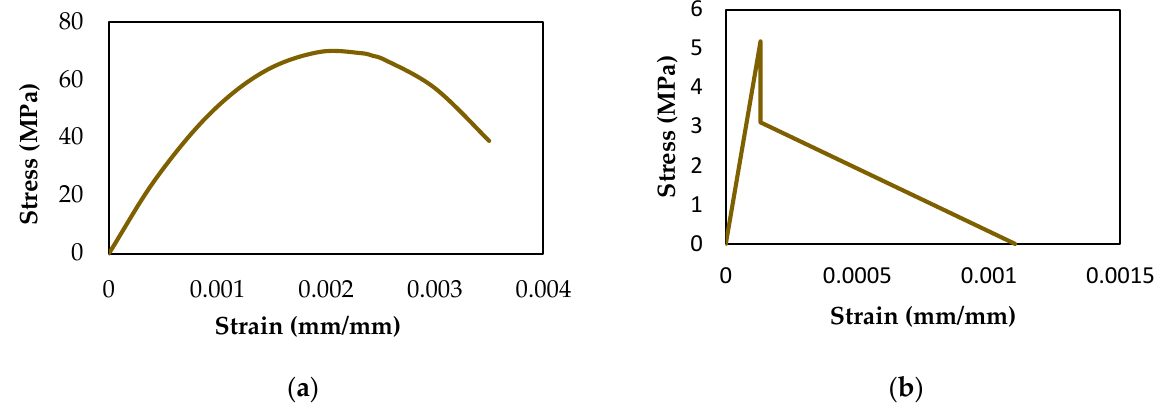
Figure 4. Constitutive models for concrete with f’ c of 70 MPa: ( a ) Compressive stress-strain curve; ( b ) tensile stress-strain curve.